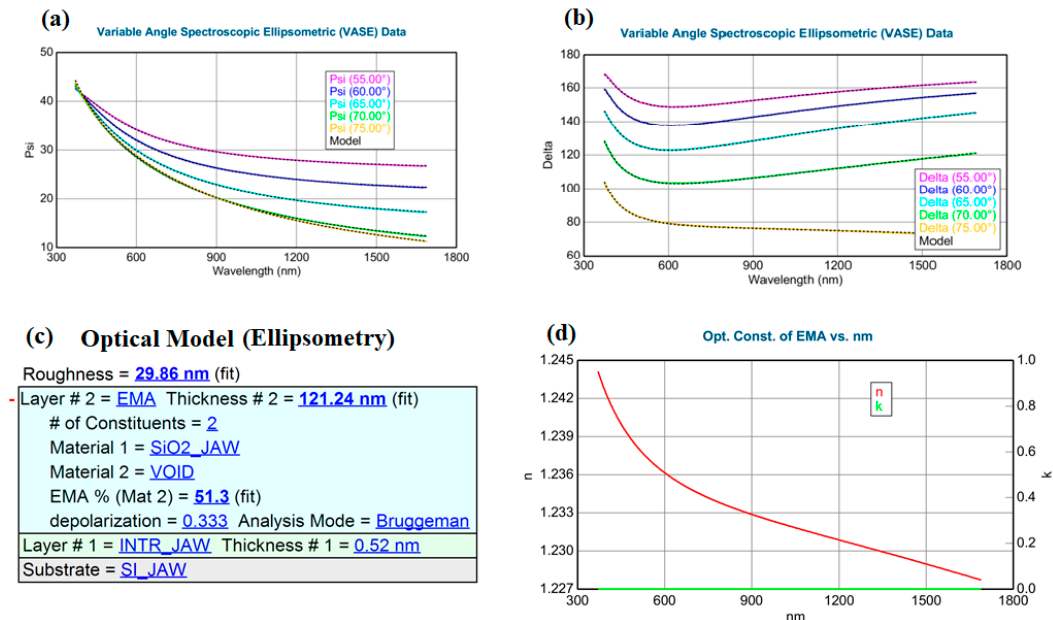
Figure 7. ( a ) Spectroscopic ellipsometry results of coated film, ( b ) showing that the experimental and generated model data fit well with each other, and ( c , d ) showing the optical model result, the measured porosity, roughness, and refractive index, which are 51%, 29.86 nm, and 1.23 at 600 nm, respectively.